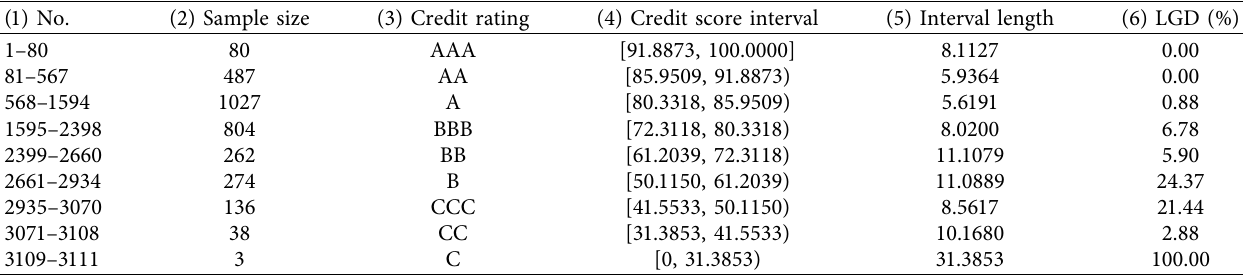
Table 7: Credit rating results based on K-means clustering.